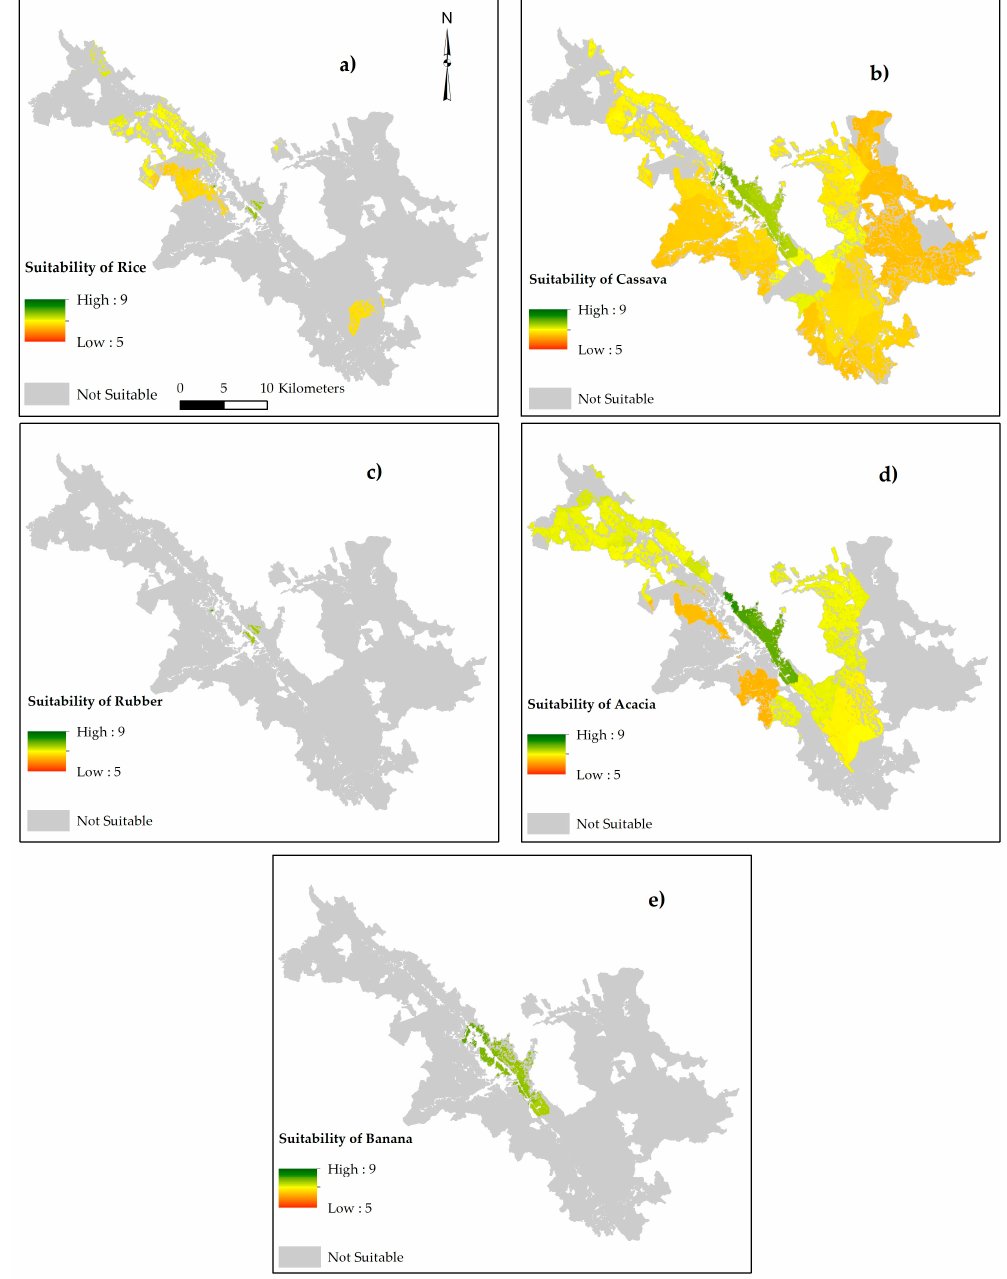
Figure 7. Land suitability for selected land use types: ( a ) suitability of rice; ( b ) suitability of cassava; ( c ) suitability of rubber; ( d ) suitability of acacia, and, ( e ) suitability of banana.